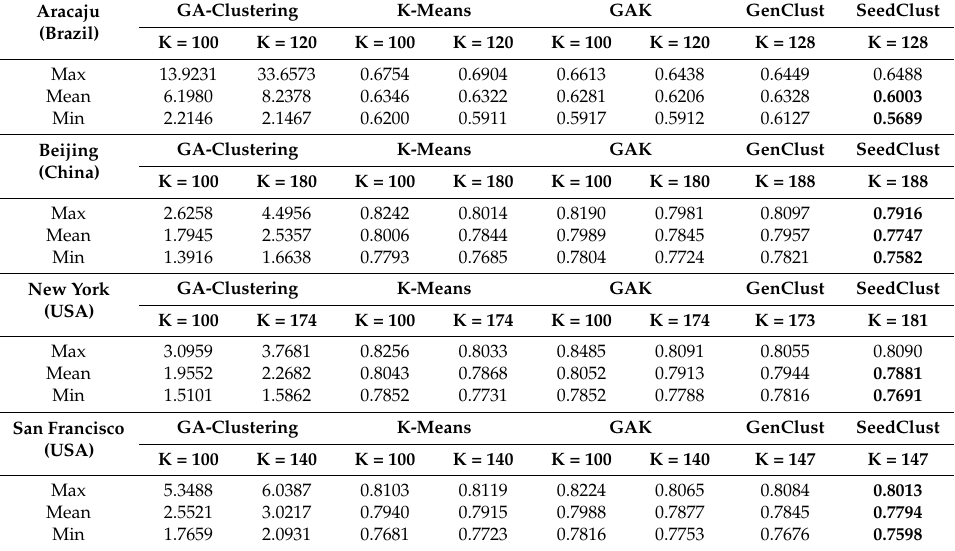
Table 4. The maximum, mean, and minimum values of Davies-Bouldin index (DBI) obtained by GA-clustering, GAK, K-means, and SeedClust algorithms for 20 different runs for four real-world taxi GPS data sets.